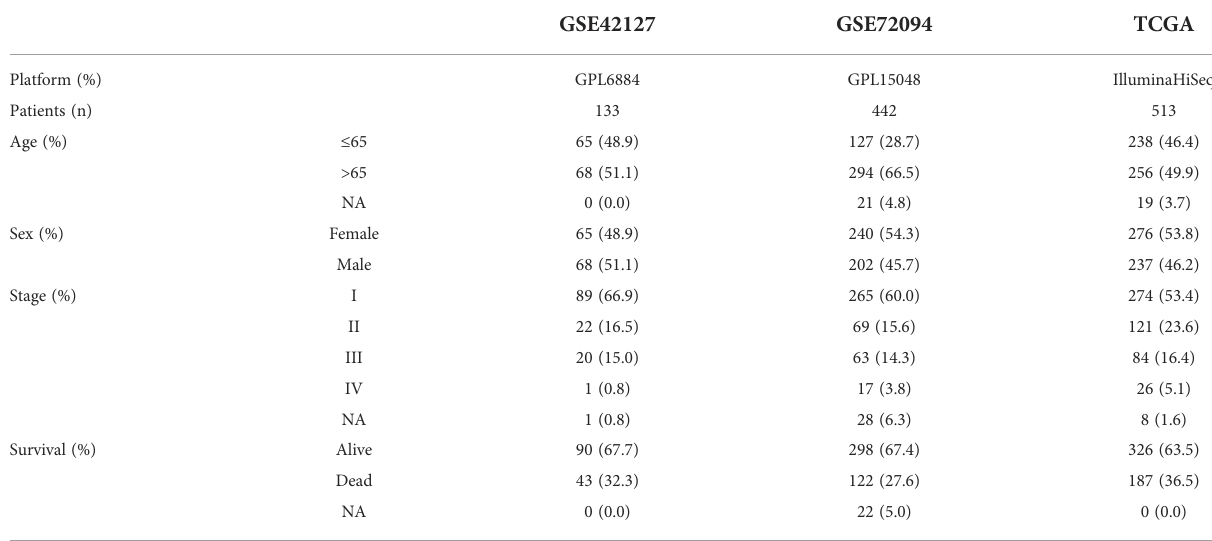
TABLE 1 Clinical characteristics of patients with LUAD in each